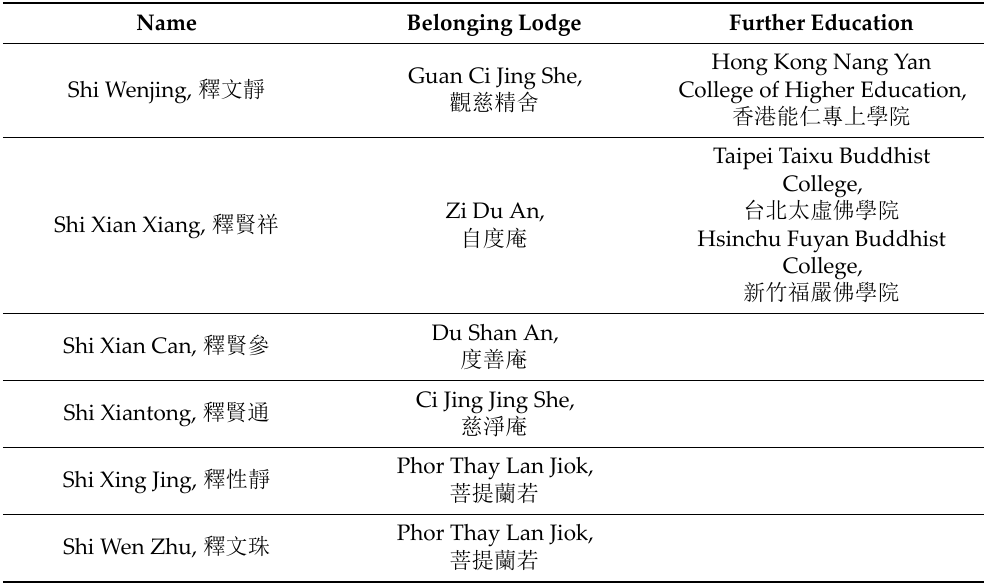
Table 4. SGBI‑graduated bhikkhunis 1